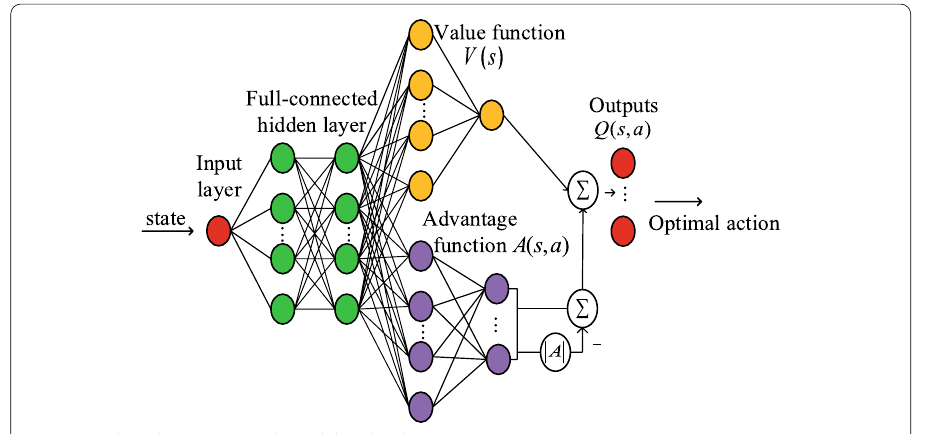
Fig. 2 Dueling deep Q-network model and